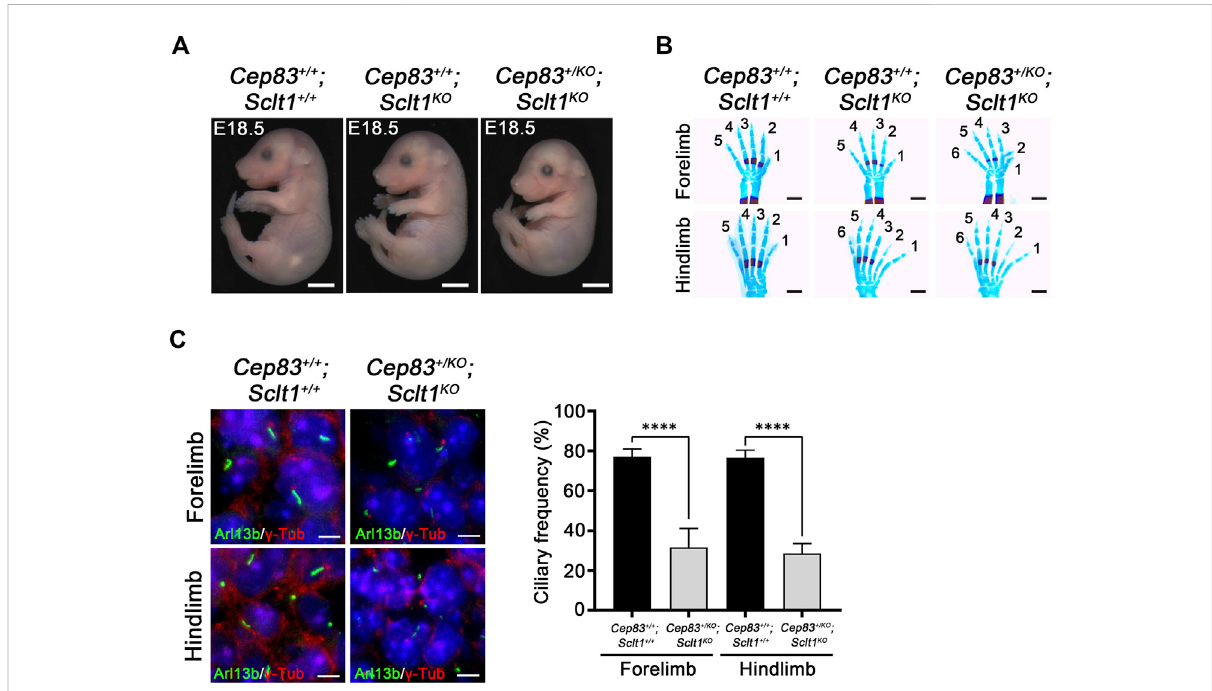
FIGURE 4 Heterozygosity of Cep83 in Sclt1 mutant induces fore- and hindlimb polydactyly (A) Photomicroscopic image to compare the gross morphologyofthe Sclt1 singlemutant, Sctl1 KO ,andheterozygous Cep83 combinedwith Sclt1 nullmutant, Cep83 +/KO ;Sctl1 KO withcontrolembryosat E18.5.Scalebars=2 mm (B) ToevaluatethegeneticinteractionofCep83withSclt1inlimbdigitspeci fi cation,weexaminedthedigitpatterninginthe Sclt1 single mutant, Cep83 +/+ ; Sclt1 KO ; Cep83 and Sclt1 double mutant, Cep83 +/KO ; Sclt1 KO ; and control littermates, Cep83 +/+ ; Sclt1 +/+ , by staining limbs withalcianblue/alizarin red.Heterozygouslossof Cep83 gene with Sclt1 homozygotemutantaffectsforelimb andhindlimbdigitspeci fi cation at E18.5. Scale bars = 500 µm (C) Immuno fl uorescent images were taken from cryosectioned E11.5 embryo limbs and analyzed with anti-Arl13b (green)and γ -Tubantibodies(red).Representativeimageswereshownintheleftpanelandquantitativeresultspresentedintherightpanel.Errorbars represent SEM and asterisks denote statistical signi fi cance according to Student ′ s t tests (**** p <